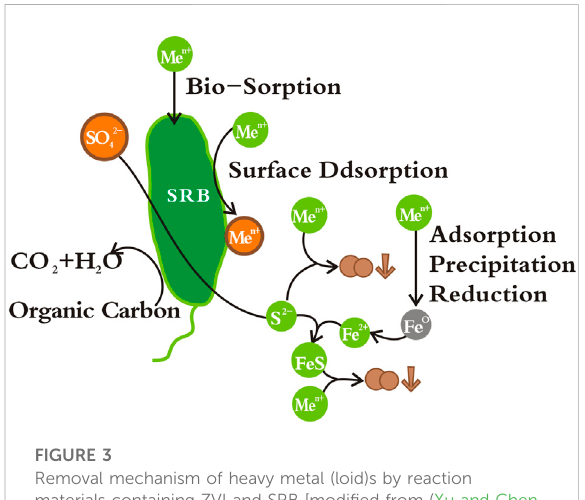
FIGURE 3 Removal mechanism of heavy metal (loid)s by reaction materials containing ZVI and SRB [modi fi ed from (Xu and Chen, 2020; Song J. et al., 2021)].